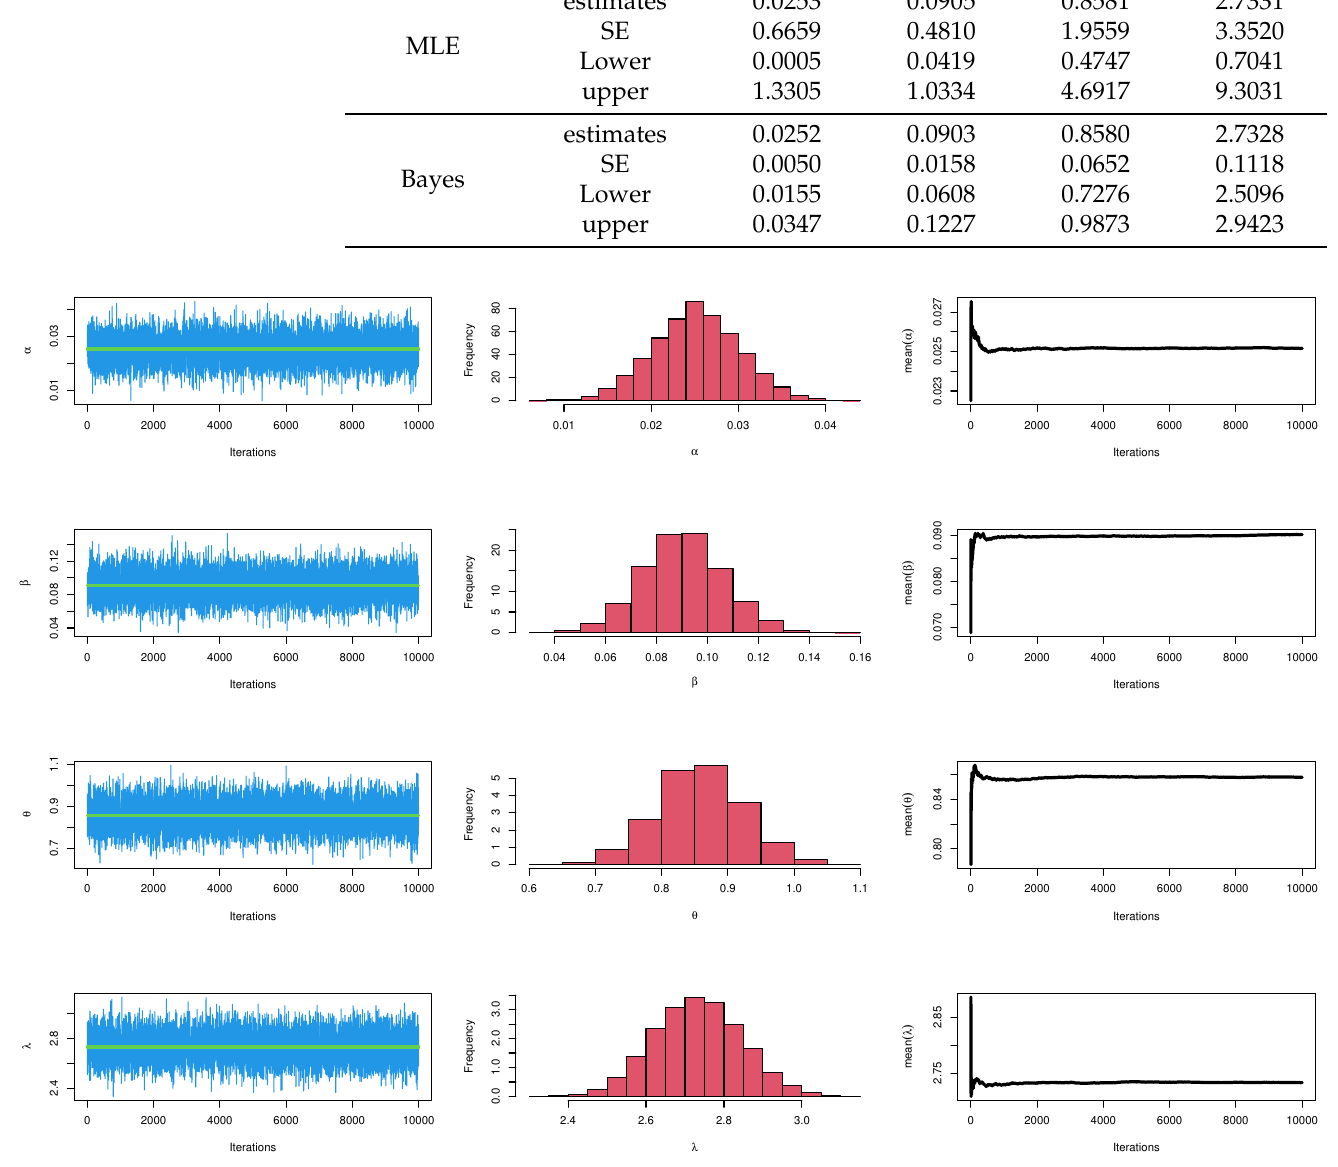
Figure 21. MCMC plots for parameters of TLMW model for waiting